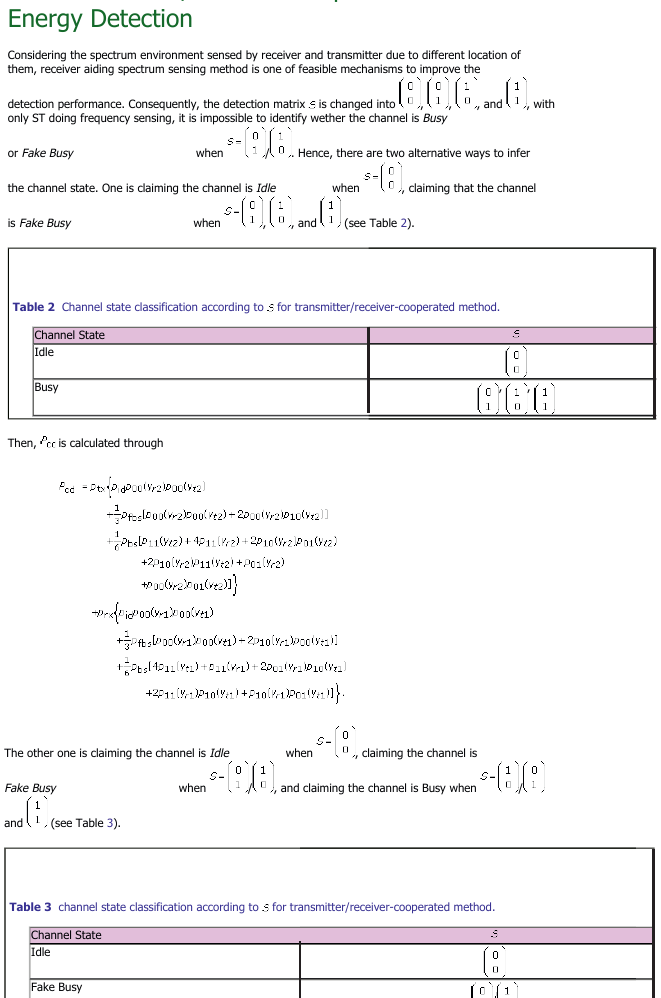
Table 3 channel state classification according to for transmitter/receiver-cooperated